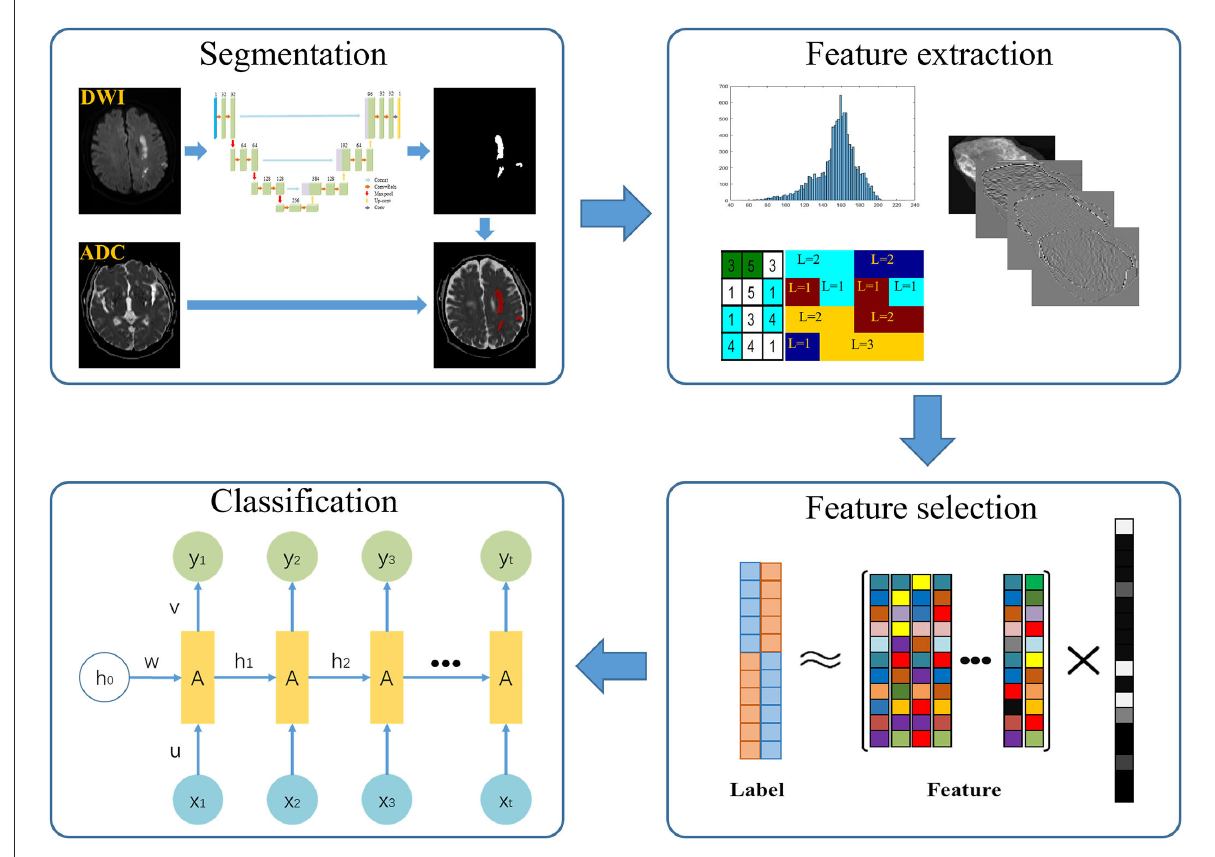
FIGURE2 Pipeline of radiomics analysis of ischemic stroke on diffusion-weighted imaging.